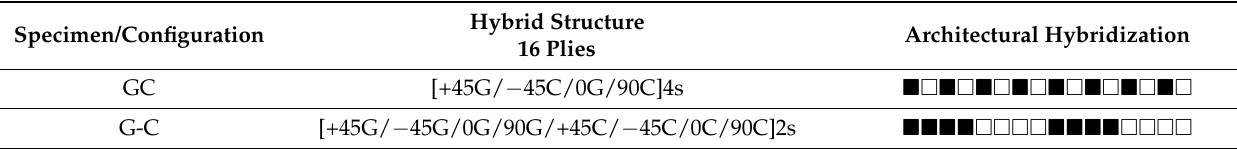
Table 1. Hybrid composite configurations developed within the present study.